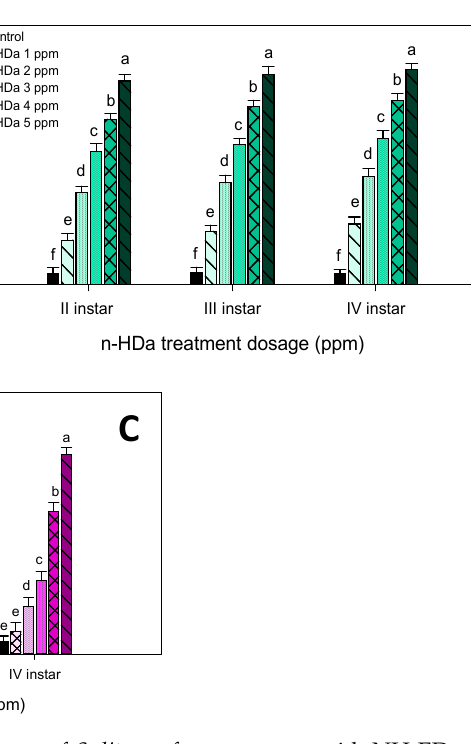
Figure 3. Percentage mortality of second, third, and fourth instar larvae of S. litura after treatment with NH-EDx ( A ), n -HDa ( B ), and n -ODa ( C ). Means (±SEM) followed by the same letters above bars indicate no significant difference ( P ≤ 0.05) according to a Tukey’s test.